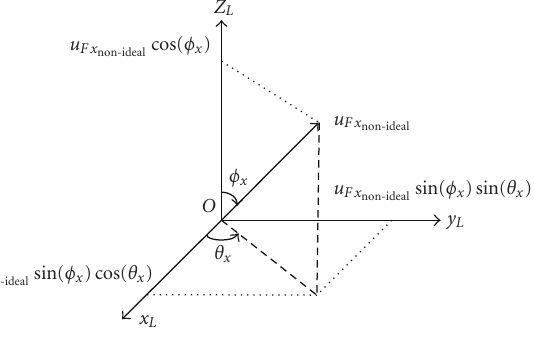
Figure 12: Nonideal placement of u f